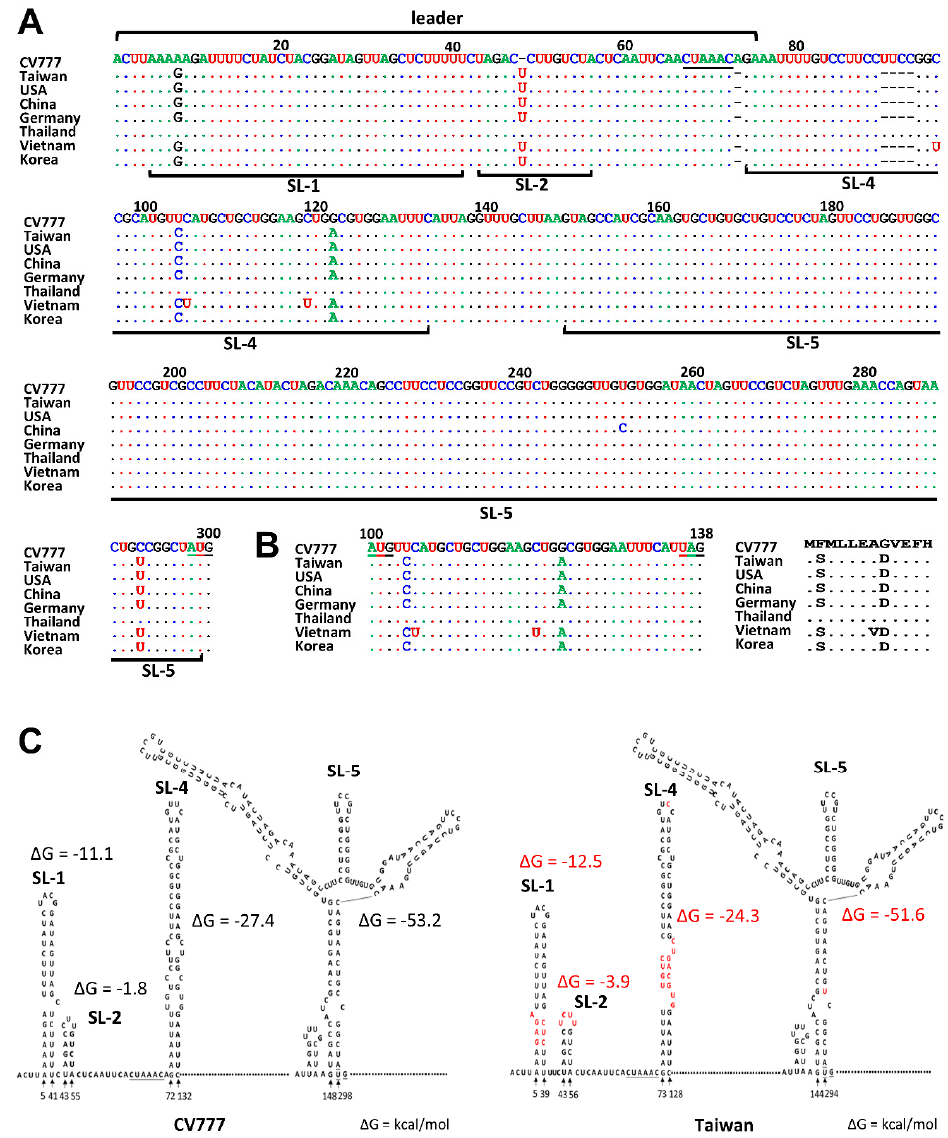
Figure 1. Sequences and structures of the porcine epidemic diarrhea virus (PEDV) 5 ′ untranslated region (UTR). ( A ) Nucleotide sequence alignment of the 5 ′ UTR between CV777, Taiwan (TW), and reference strains. The position numbers refer to the composite sequence. Nucleotide identity between sequences is indicated with a dot; a difference is indicated with a new letter code. A gap is indicated with a dash. Underlining indicates the core sequence of the leader (CS-L) (nt 67–72) and the start codon for ORF 1a (nt 298–300). ( B ) Alignment of the nucleotide sequence (left panel) and deduced amino acid sequence (right panel) of the upstream open reading frame (uORF) for CV777, TW, and reference strains. ( C ) Structure prediction of the 5 ′ UTR of strains CV777 (left panel) and TW (right panel). The CS-L and start codon are indicated with underlining. CV777 (GenBank accession number AF_353511); USA (GenBank accession number KF_468572); China (GenBank accession number KC_210145); Germany (GenBank accession number LM_645058); Thailand (GenBank accession number KR_610991); Vietnam (GenBank accession number KJ_960179); Korea (GenBank accession number KJ_662670).